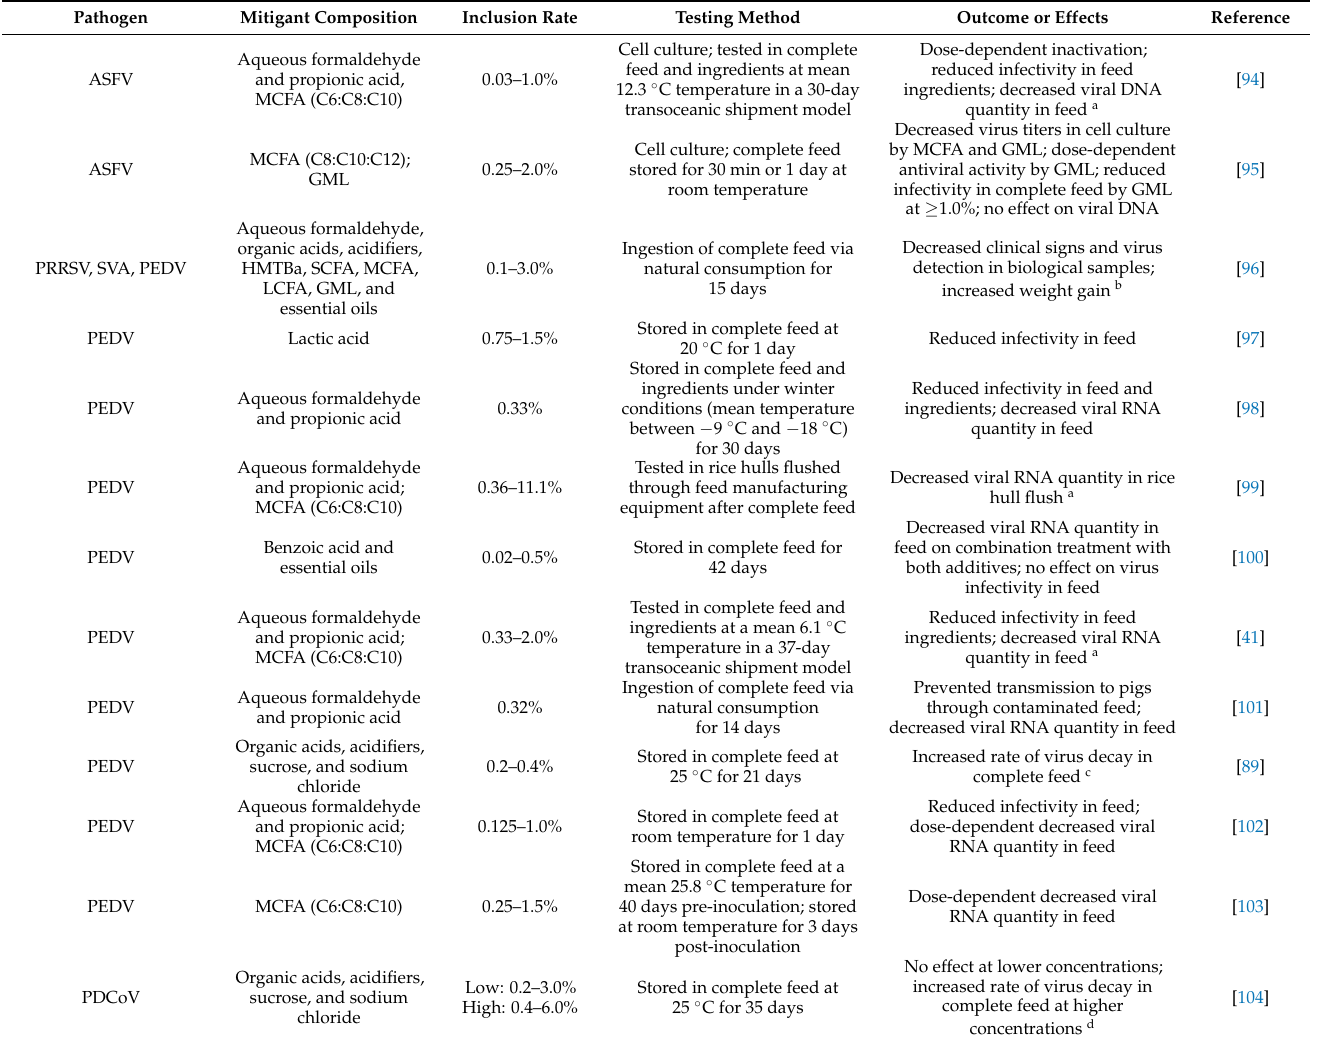
Table 2. Studies reporting the efficacy of various feed additives in mitigating the risk of porcine viruses in feed. Pathogen Mitigant Composition Inclusion